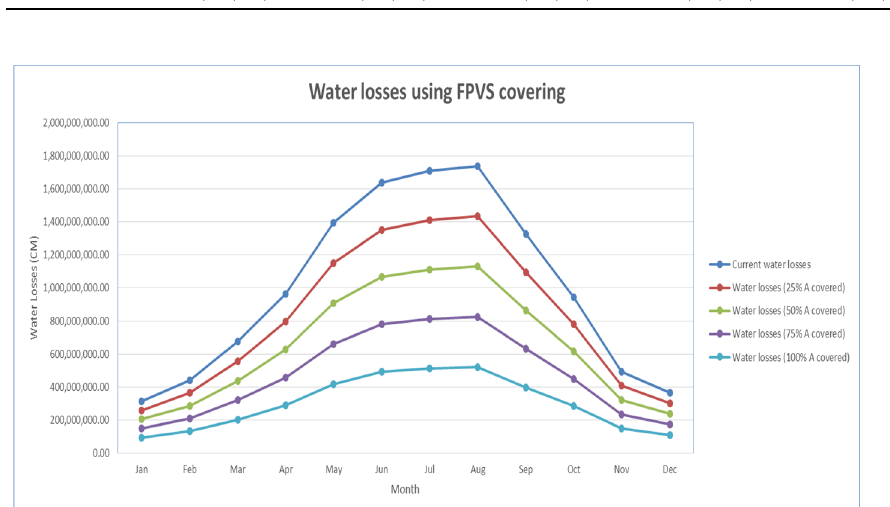
Figure 7. Monthly water losses after using an FPVS at Lake Nasser.